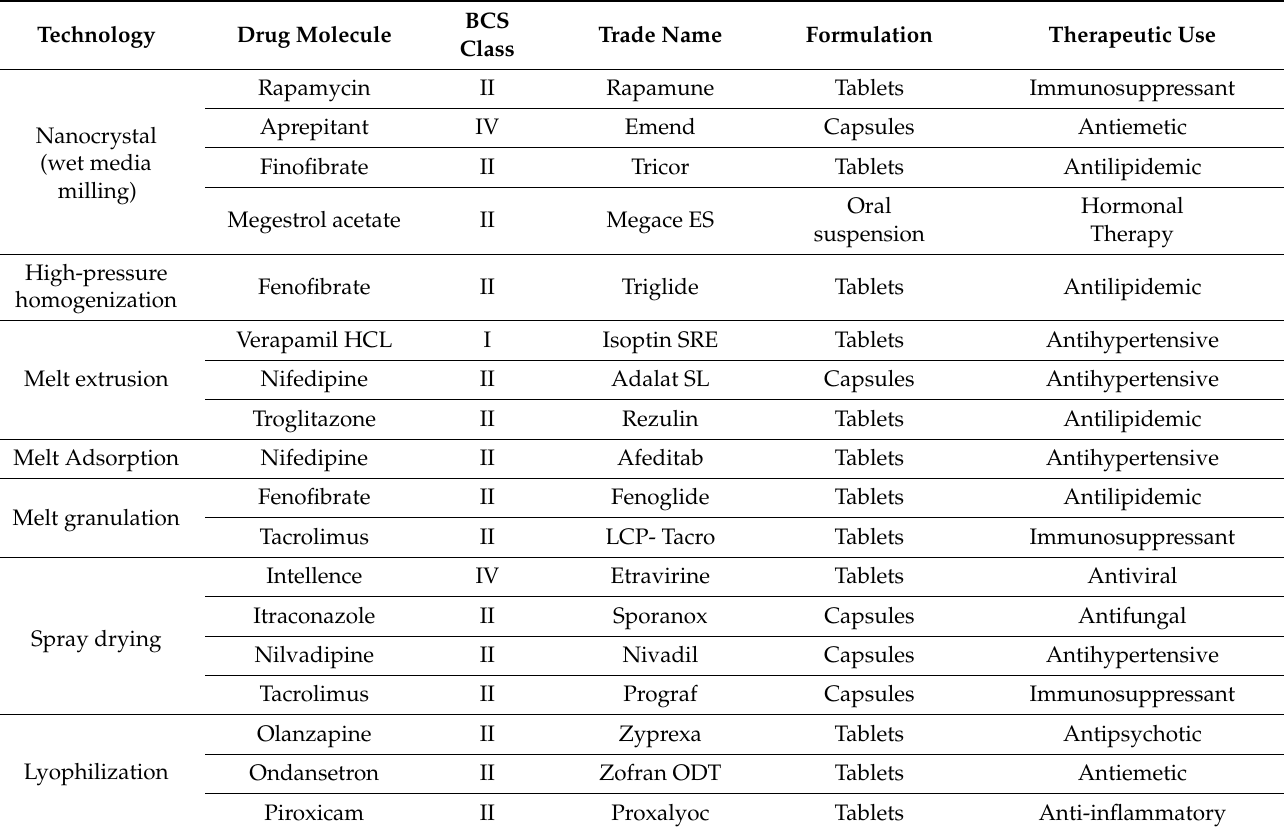
Table 6. Manufacturing technologies of solid